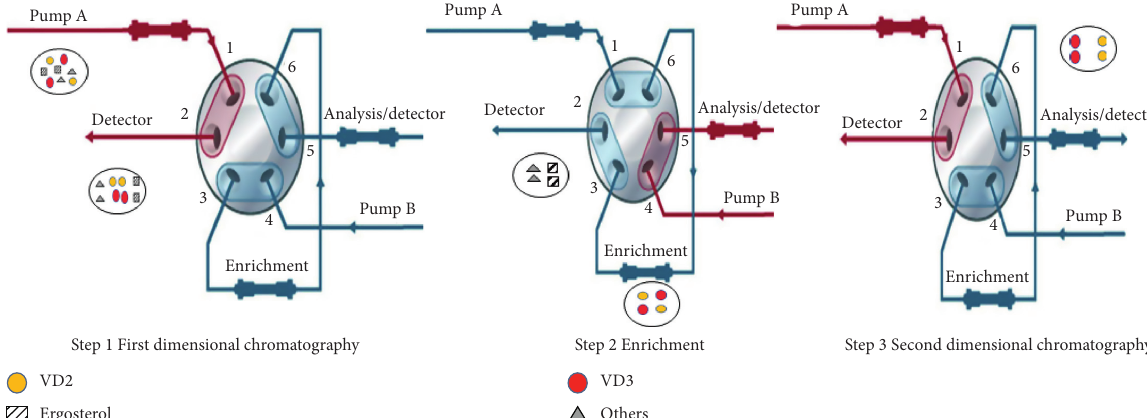
Figure 2: The diagram of system connection and the flow diagram of the analysis